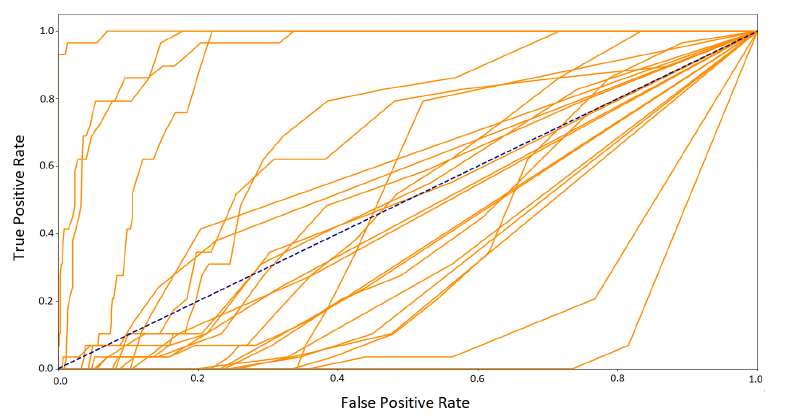
Figure 13. ROC–RF for 24 classes. The train and test sets based on the different